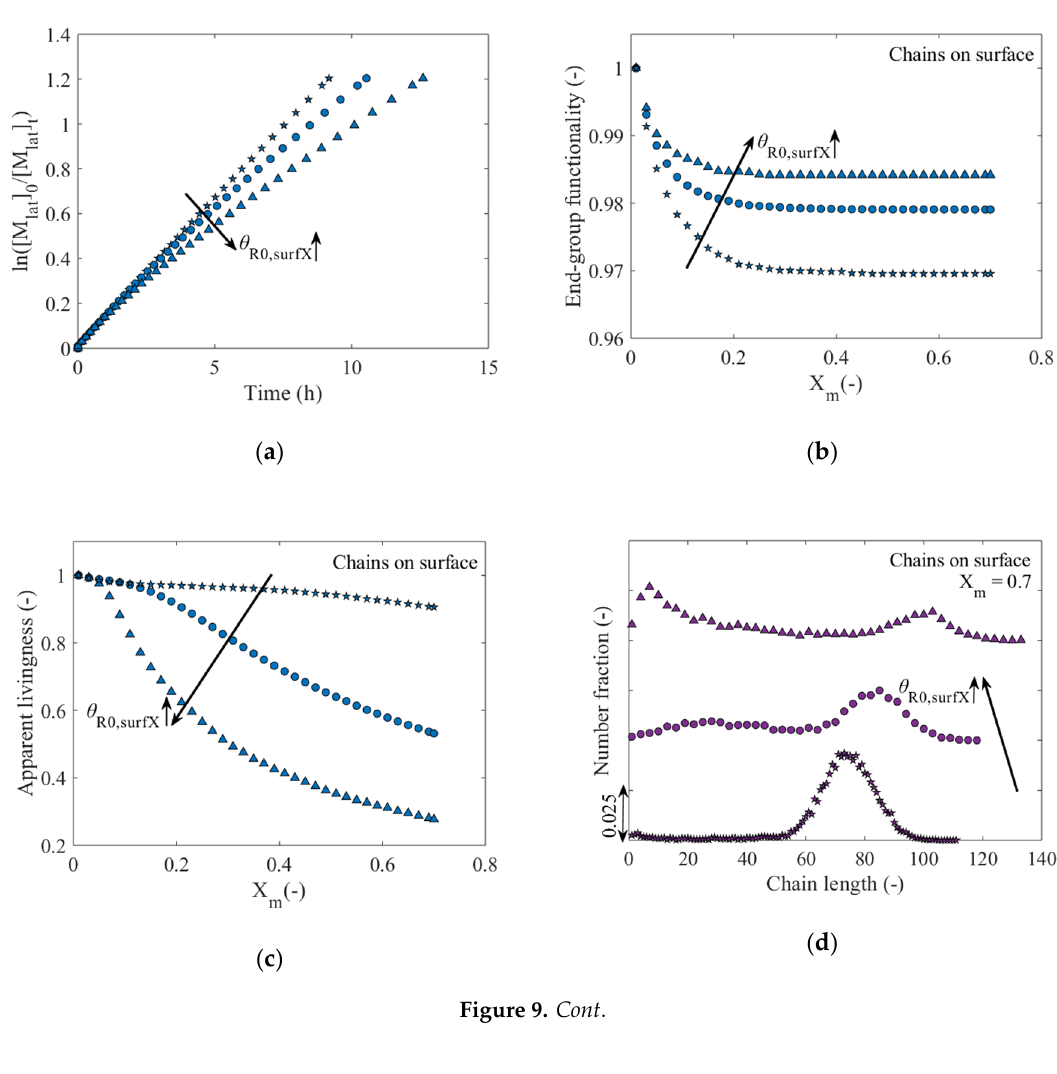
⁄ ) as a function ] [ M ] lat lat 0 t